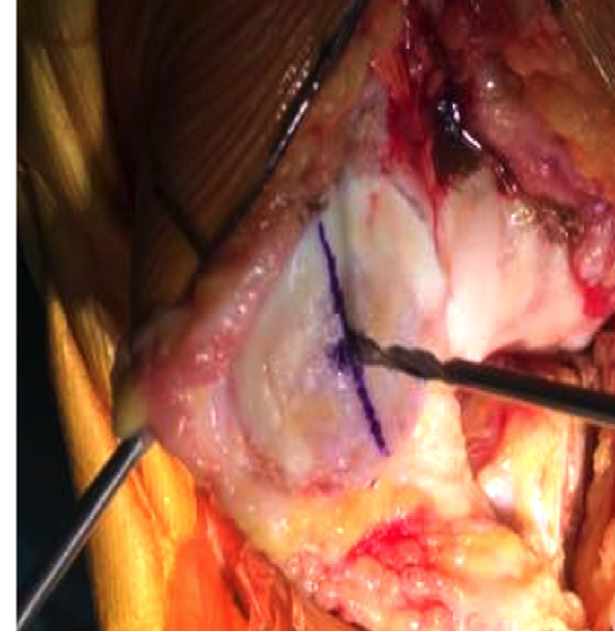
Figure 3. Tunnel drilled perpendicularly over OCPP.